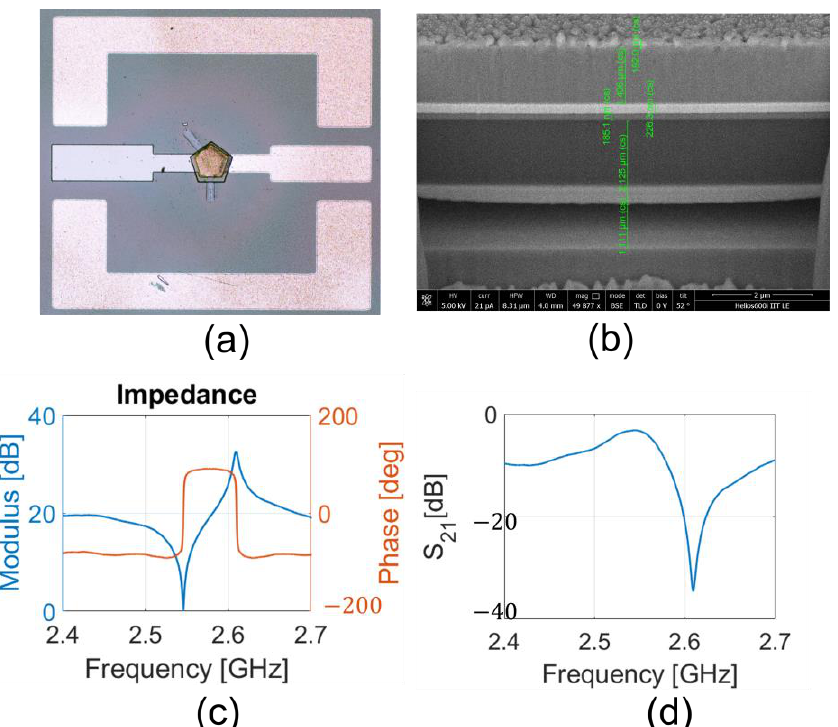
Figure 4. Characterization of the air-gap resonator. ( a ) Optical microscope top-view of the resonator, ( b ) SEM cross-section of the stack, ( c ) measured impedance of the resonator, and ( d ) scattering parameter S 21 .